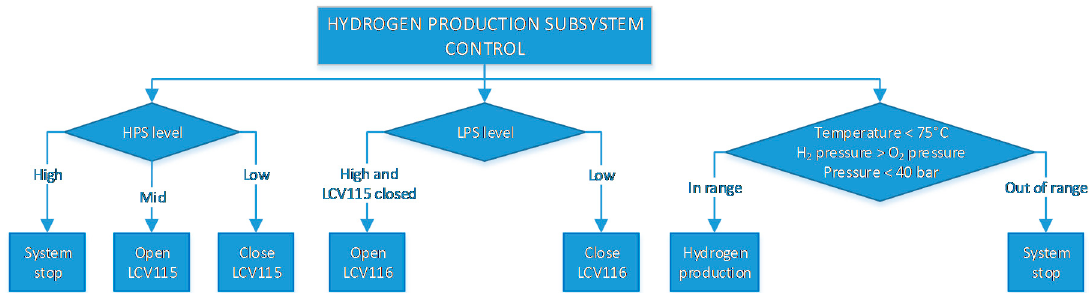
Figure 7. PEM electrolyzer control flow diagram: hydrogen production subsystem.